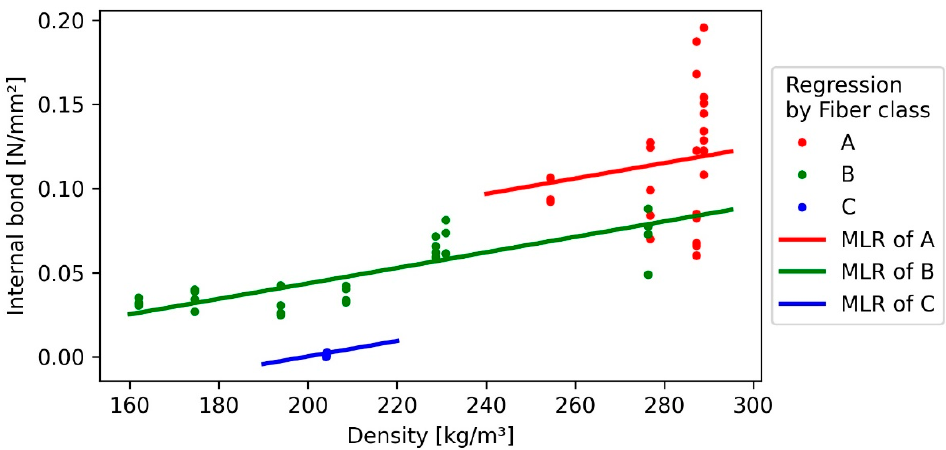
Figure 6. Multiple linear regression (MLR) of internal bond towards the independent variables density and bark fibre length (lines) and measured values (points).